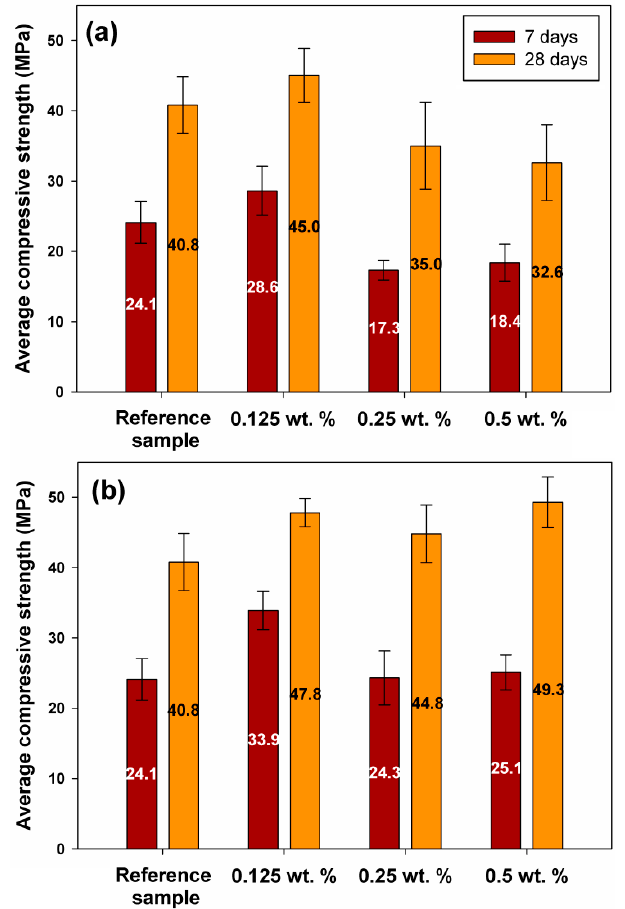
Figure 5. Compressive strength results for samples containing different quantities of lignosulfonate ( a ) and lignin ( b ).